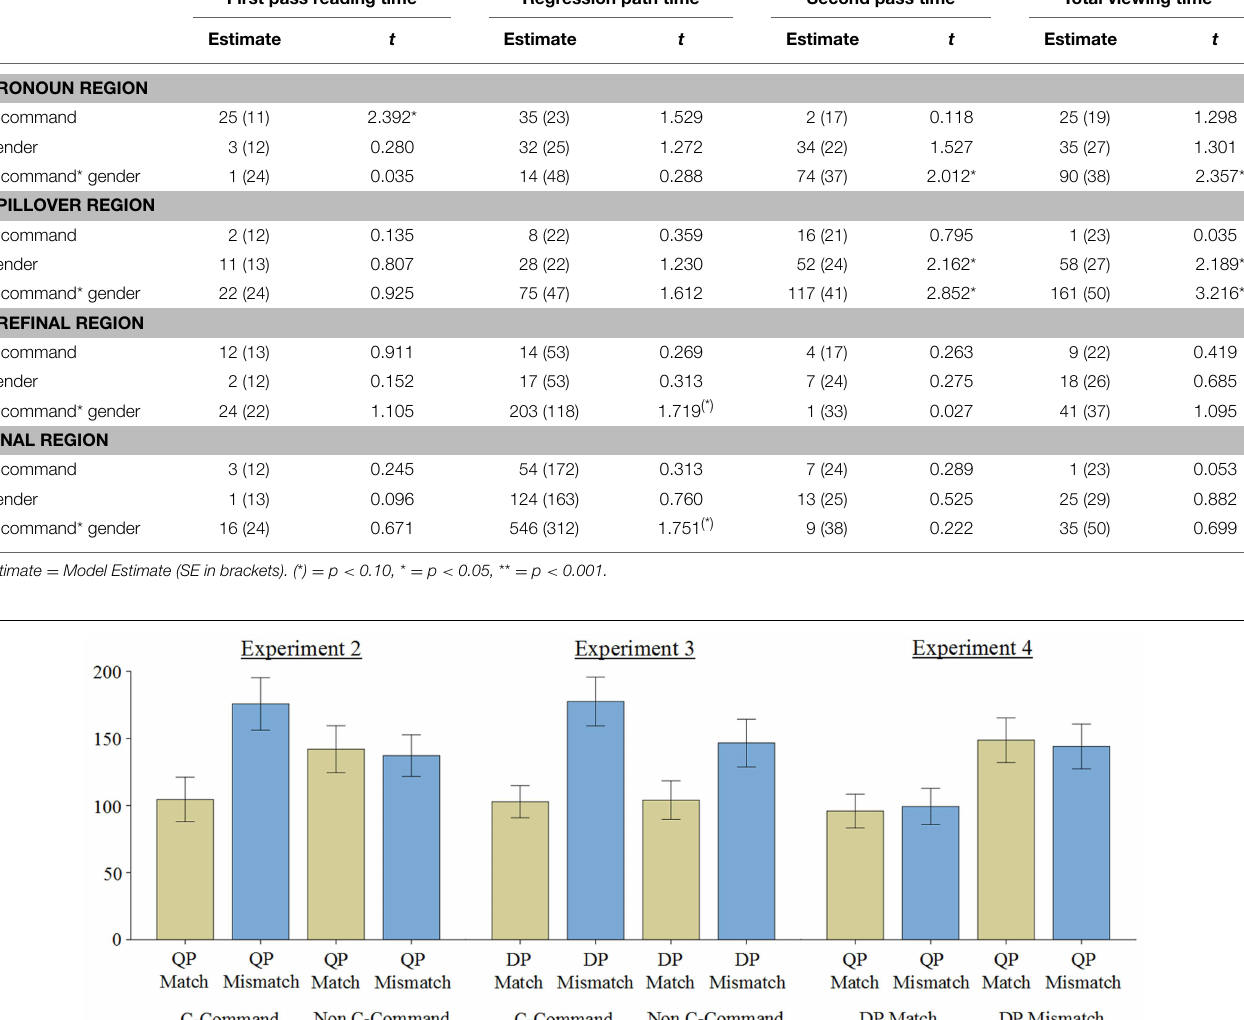
TABLE 2 | Summary of statistical analyses for four eye-movement measures at four regions of texts in Experiment 2. First pass reading time